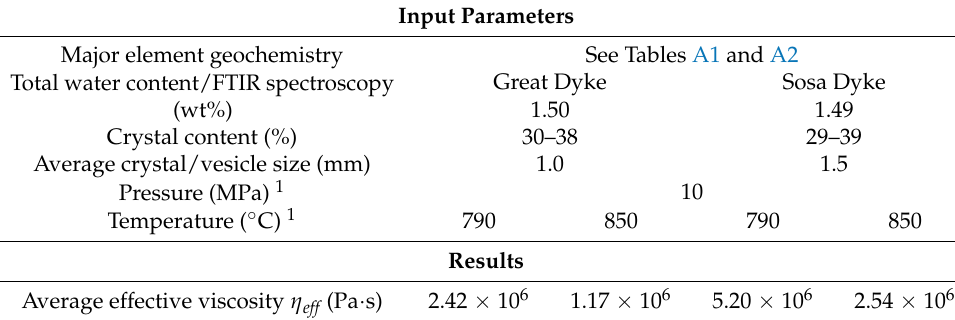
Table 1. Input parameters for MAGMA (Kware) viscosity